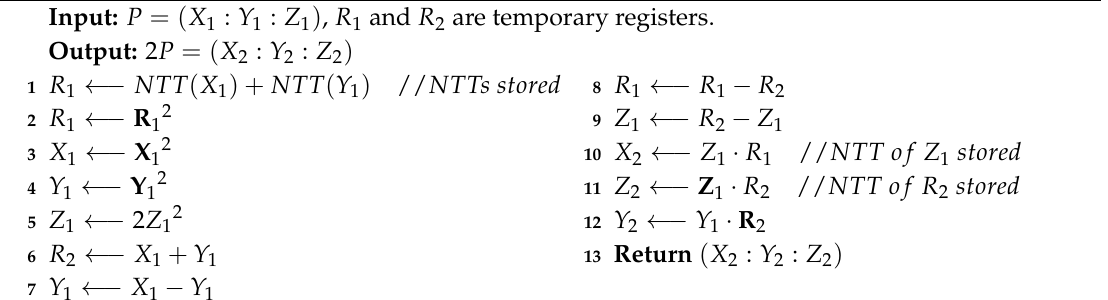
Algorithm 6: Elliptic curve point doubling in projective coordinates over prime fields using Edwards curves and NTT-based